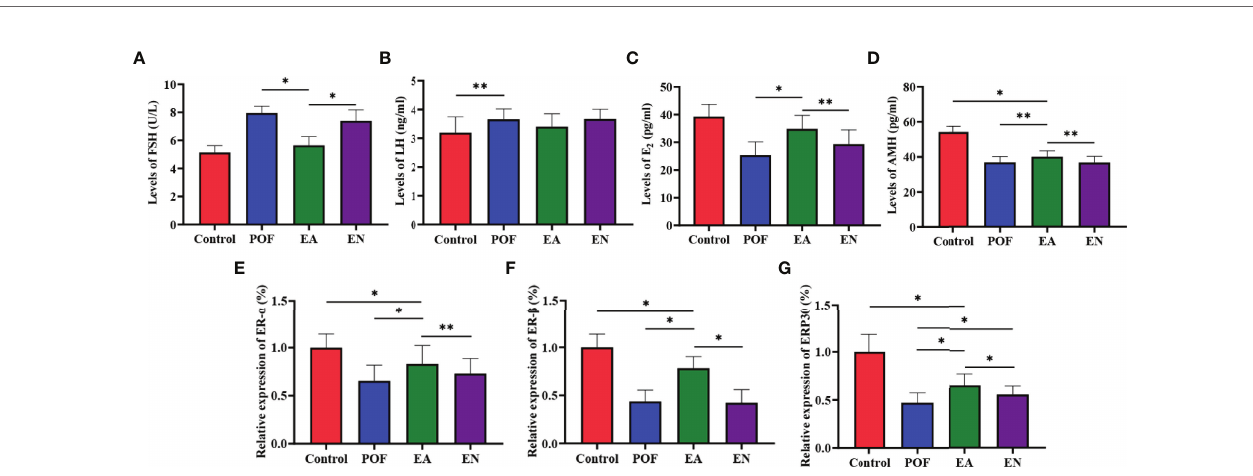
FIGURE 4 | The levels of sex hormones were detected by ELISA (A) , FSH; (B) , LH; (C) , E2; (D) , AMH.) and the relative expression of estrogen receptor (E) , ER- a ; (F) , ER- b ; (G) , GRP30) (* means P < 0.05; ** means P <